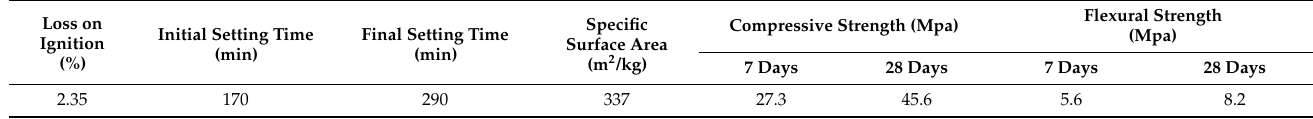
Table 1. Properties of